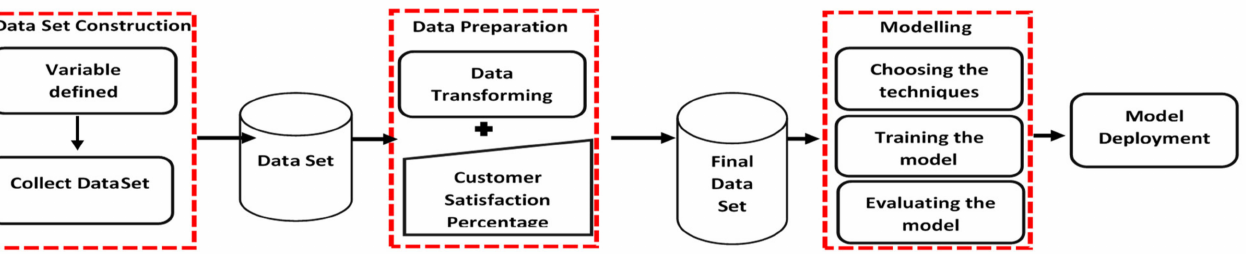
Figure 1. Our SentiChurn model approach.